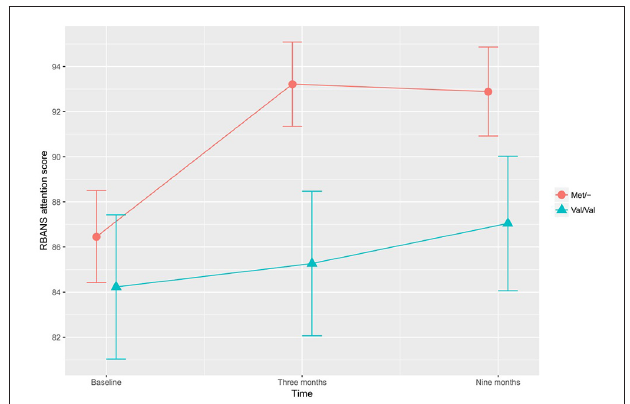
FIGURE 2 | The effects of BDNF polymorphism on attention. Met/- carriers performed better than Val/Val carriers on the RBANS attention tasks across all time points, F ( 1,97 ) = 3.929, p = 0.050. Note: RBANS, Repeatable Battery for the Assessment of Neuropsychological Status. The error bars represent standard errors.